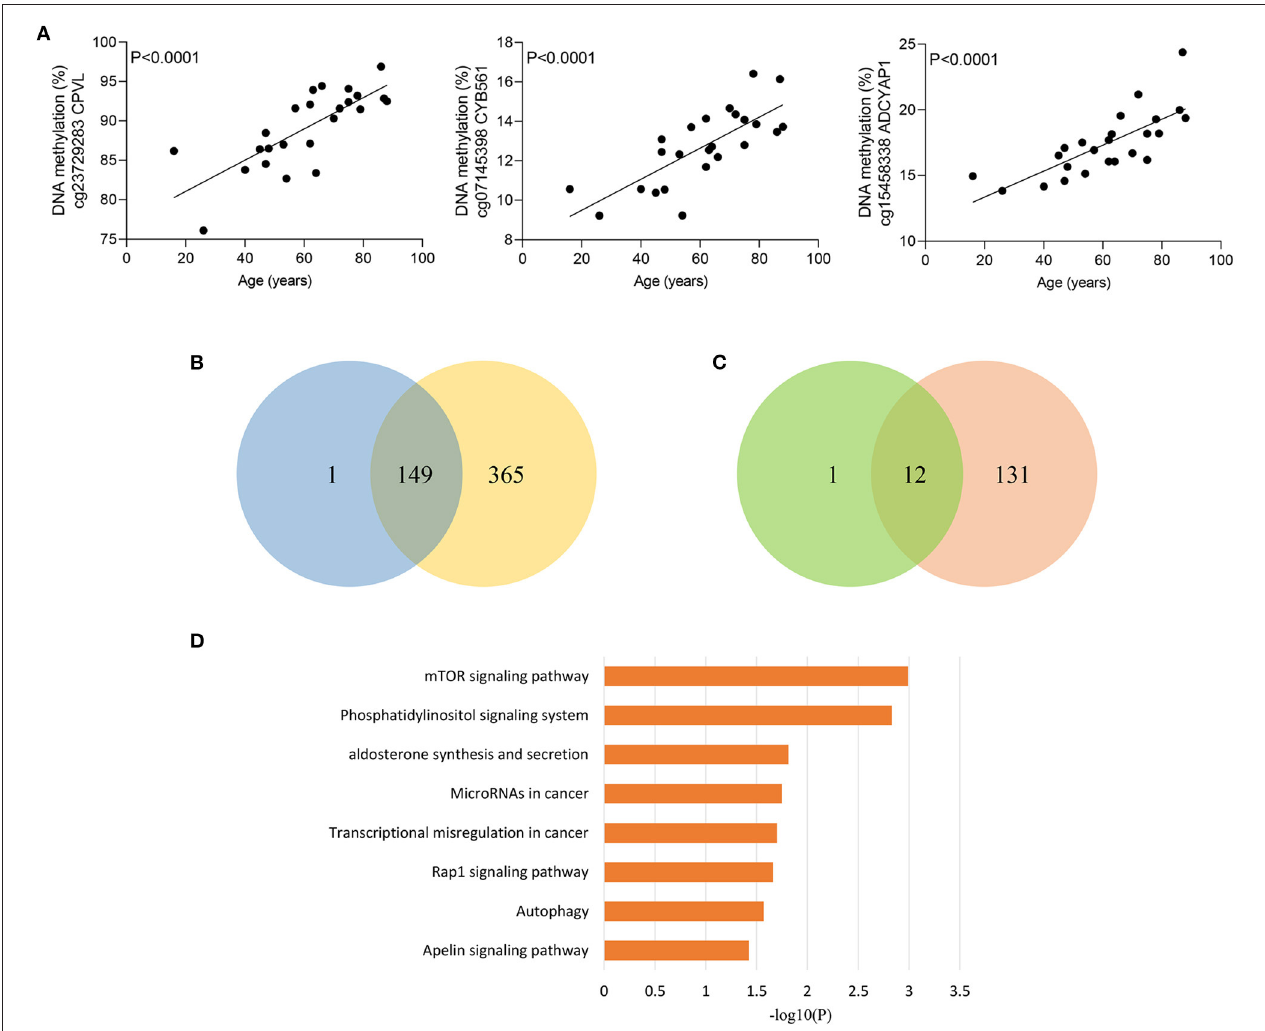
FIGURE 4 | Age-related methylation changes in sepsis patients. (A) Correlation between age and methylation of three CpG sites with the most significant correlations with age in sepsis patients as analyzed by linear regression analysis ( n = 24). (B) Venn diagram showing the intersection of the sets of hypermethylated sites with increasing age in sepsis and hypermethylated sites in non-survivors. (C) Venn diagram showing the intersection of the sets of hypomethylated sites with increasing age in sepsis and hypomethylated sites in non-survivors. (D) Kyoto Encyclopedia of Genes and Genomes (KEGG) pathway enrichment analysis of 155 genes distributed by 161 age-related CpG